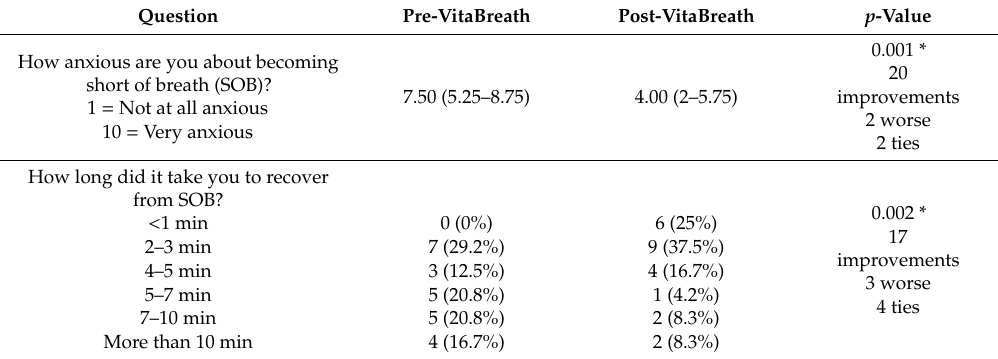
Table 4. E ff ects of the use of VitaBreath device on anxiety, symptom burden and ability to perform tasks. Question Pre-VitaBreath Post-VitaBreath p